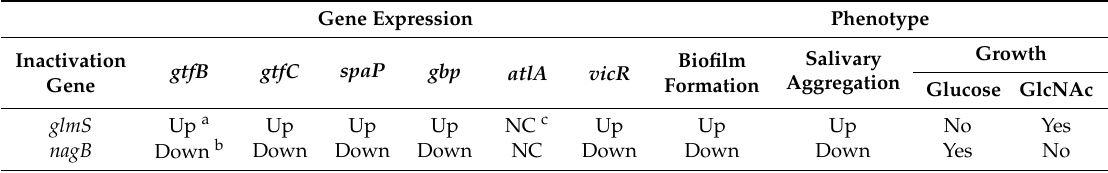
Table 1. Effect of GlmS and NagB on virulence gene expression and phenotype. Gene